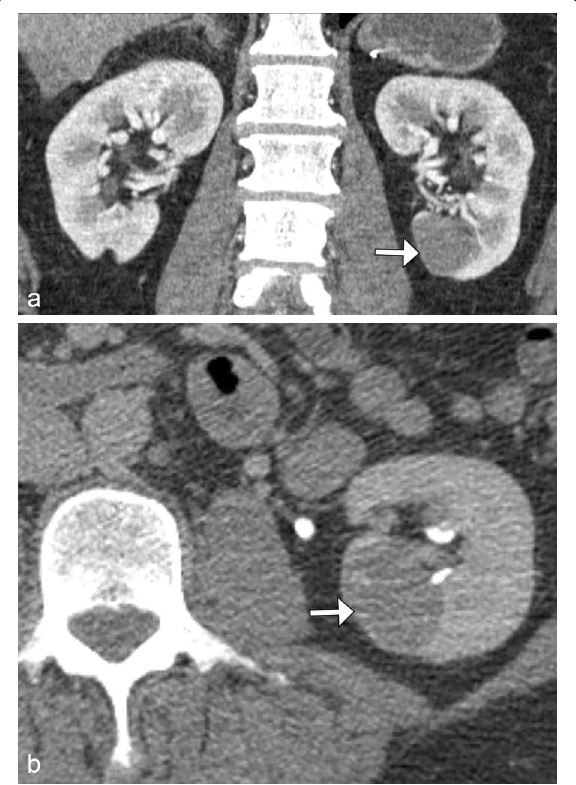
Fig. 17 Papillary renal cell carcinoma. Coronal ( a ) and axial ( b ) contrast CT images demonstrate a hypoenhancing left lower pole renal mass (arrows), which was biopsy confirmed as papillary renal cell carcinoma mimicking the solitary hypoenhancing mass